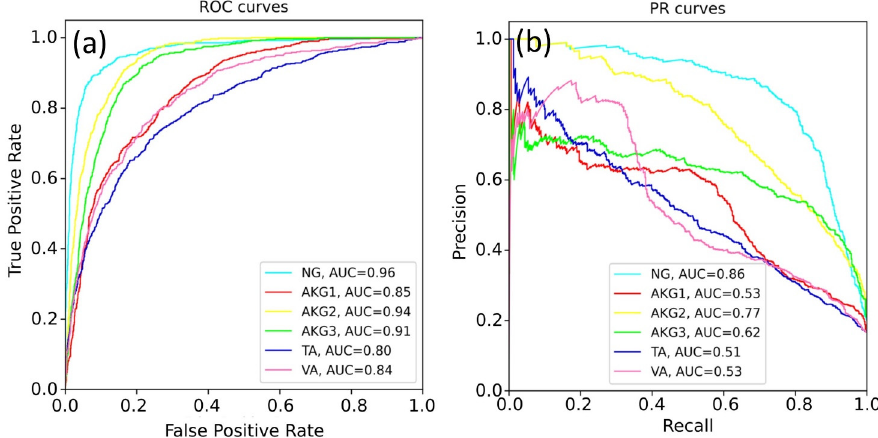
Figure 5. Changes in metrics during the training process: ( a ) the ROC-AUC metric for the adenocar- cinoma G1 class; ( b ) the PR-AUC metric for the adenocarcinoma G1 class; ( c ) the ROC-AUC metric for the adenocarcinoma G2 class; and ( d ) the PR-AUC metric for the adenocarcinoma G2 class. Figures 6 and 7 show the ROC and PR curves for the best trained models.